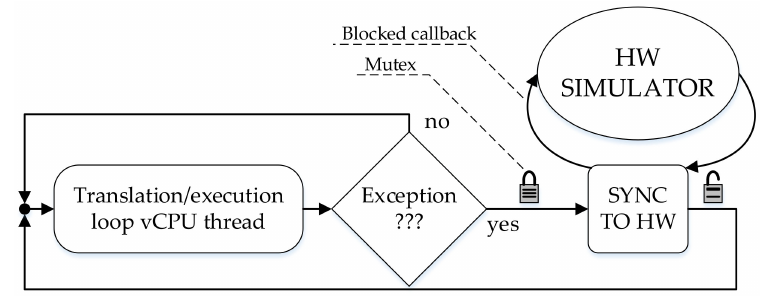
Figure 5. Flow chart for the location of the synchronization point.